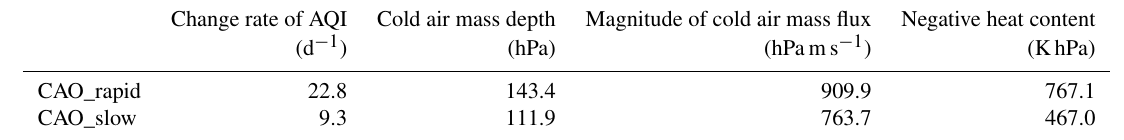
Figure 6. The same as Fig. 5 but composited by the CAO_slow events. Table 2. Averaged AQI change rate and the cold air mass properties during the period from day + 1 to +